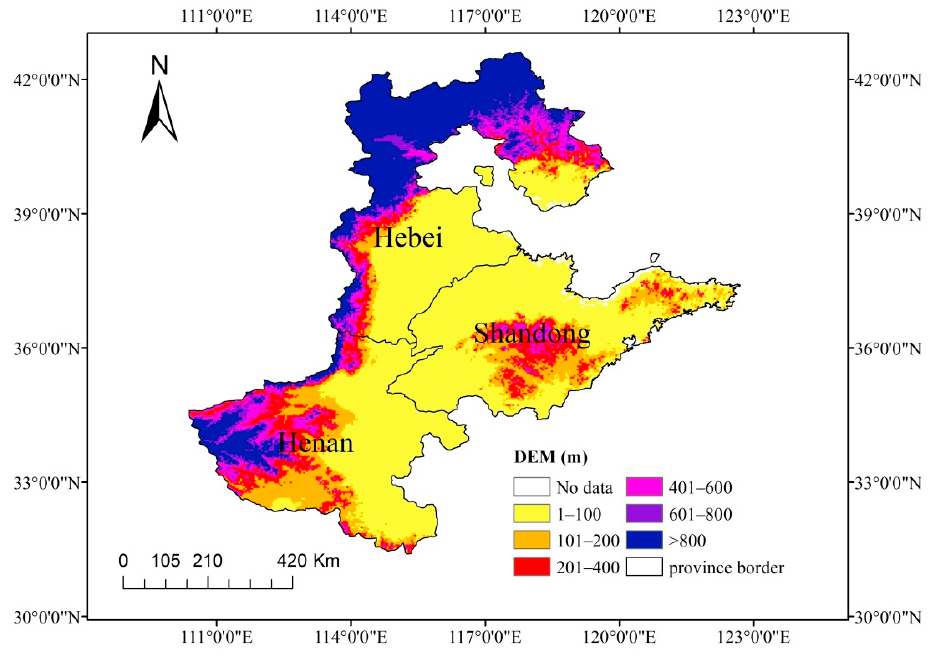
Figure 1. Location of the study area and Digital Elevation Model.